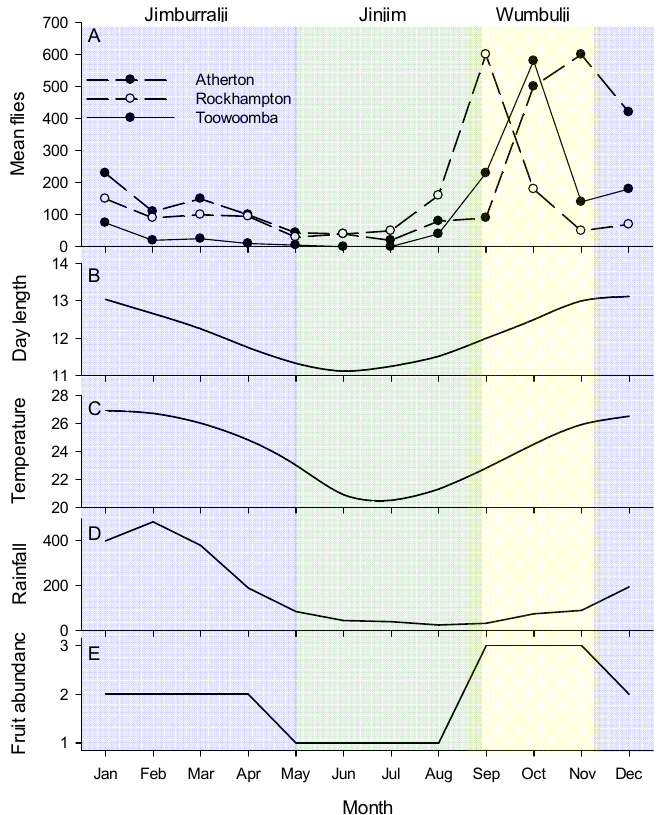
Figure 1. ( A ) Illustrative phenology patterns of Bactrocera tryoni in Australia against ( B – E ) climate variables and seasonal patterns. Atherton is in the wet tropics of Far-north Queensland (graph is the mean of four years data, 1955–1958); Rockhampton is in a dry zone located on the Tropic of Capricorn (mean of two year’s data 1955–1956); Toowoomba is a subtropical site in southern Queensland (mean of four year’s data 1950–1953). Rainfall (mm), temperature ( ◦ C) and day length (hrs) are for Cairns, a tropical city very near Atherton. Fruit abundance is a simple relative estimation (low, medium, high) of the amount of mature fruit in the tropical Australian rainforest forest based on literature [66]. The colours represent the local seasons of the Cairns district as recognised by the Yirrganydji people of Far-North Queensland. From left to right these are: (blue) Jimburralji [cyclone time], (green) Jinjim [cool time], (yellow) Wumbulji [hot and humid time]. Phenology data from Muthuthantri et al. [61], weather data from Australian Bureau of Meterology (www.bom.gov.au accessed on 7 September 2022), indigenous calander from http://www.bom.gov.au/iwk/calendars/yirrganydji.shtml (accessed on 7 September